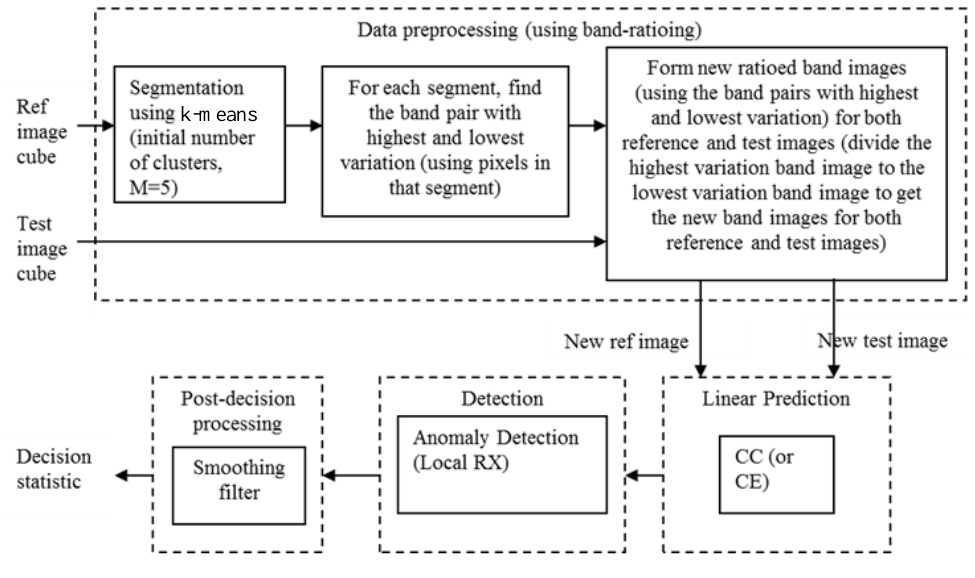
Figure 5. Block diagram of BandRatio/CC/Local RX.